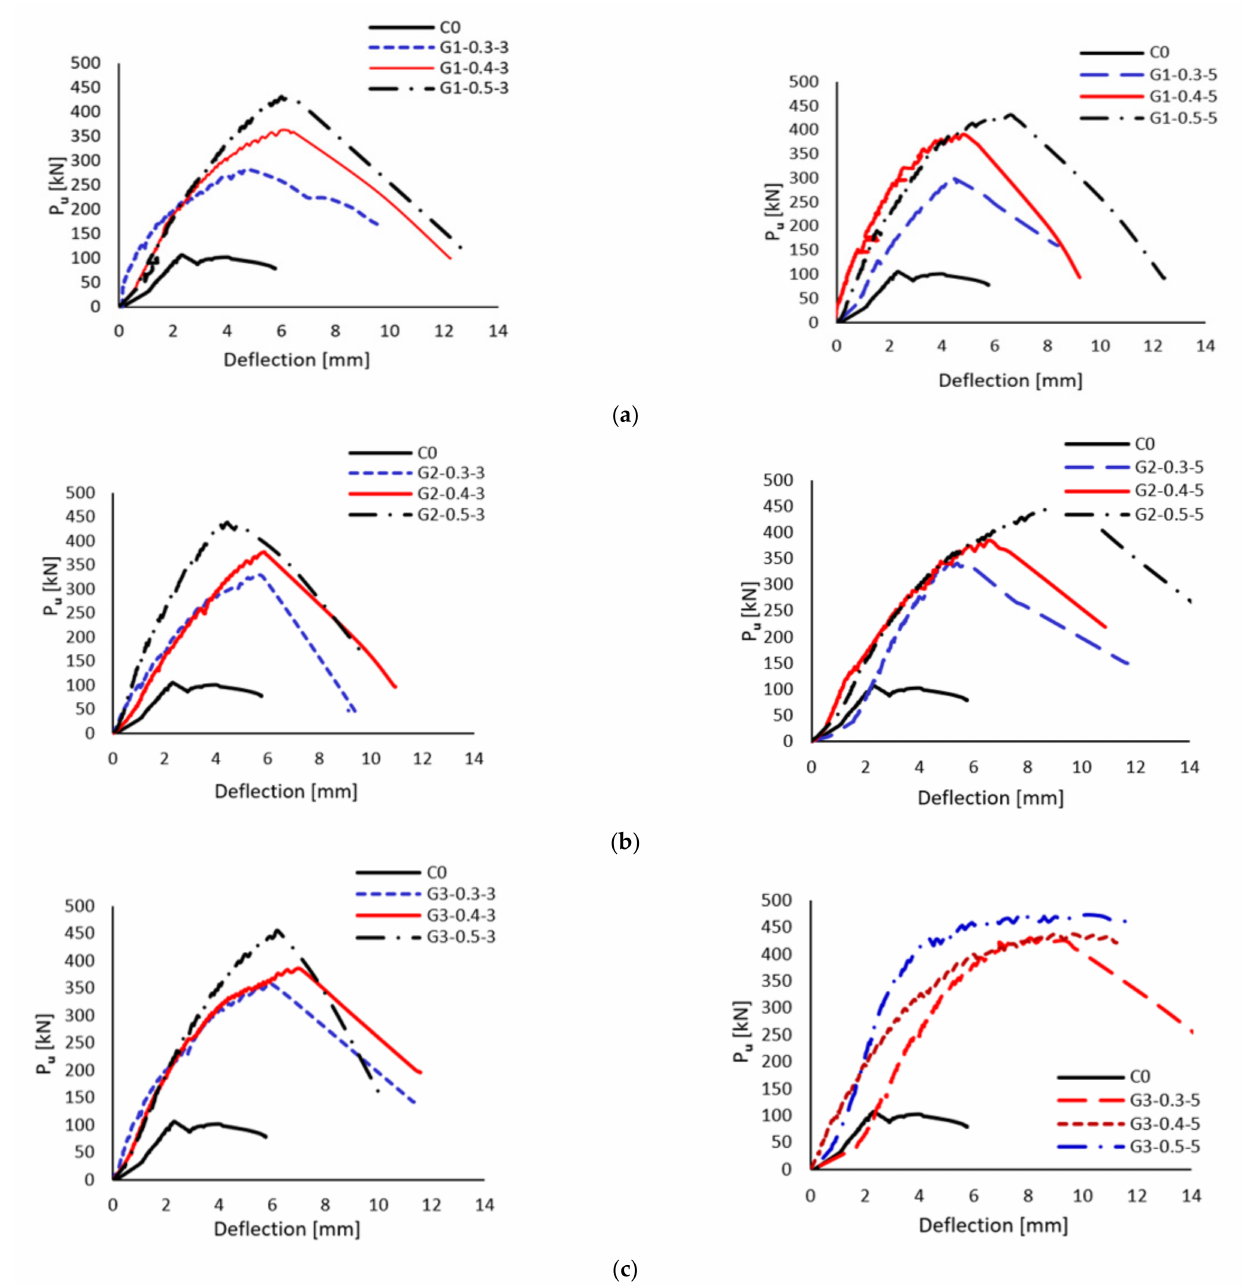
Figure 5. Load–deflection relationship for control specimen and other specimens with various flange thicknesses at flange width ratios of 3 and 5. ( a ) Specimens without reinforcement in flange. ( b ) Specimens with longitudinal reinforcement in flange. ( c ) Specimens with longitudinal steel and stirrups in